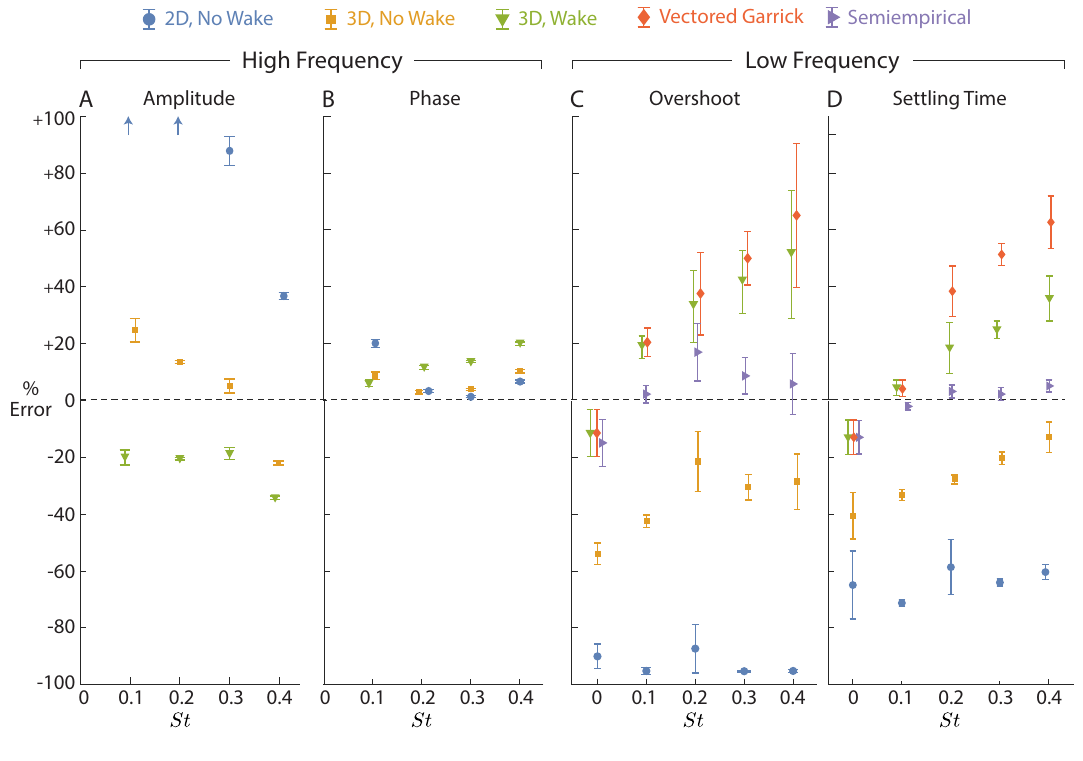
Figure 4. Predictive power varies between models and changes with Strouhal number within each model. Positive % Error implies a metric was overpredicted by the model; negative % Error implies an underprediction. Markers are sometimes shifted left/right to render them distinguishable; all data were taken at exactly St = 0, 0.1, 0.2, 0.3, or 0.4. Errors were calculated based on the high frequency content of the lateral position response (amplitude, A ; phase, B ) and the low frequency content of the lateral position response (overshoot, C ; settling time, D ). High frequency predictions for the Vectored Garrick and Semiempirical models are the same as the 3D Wake